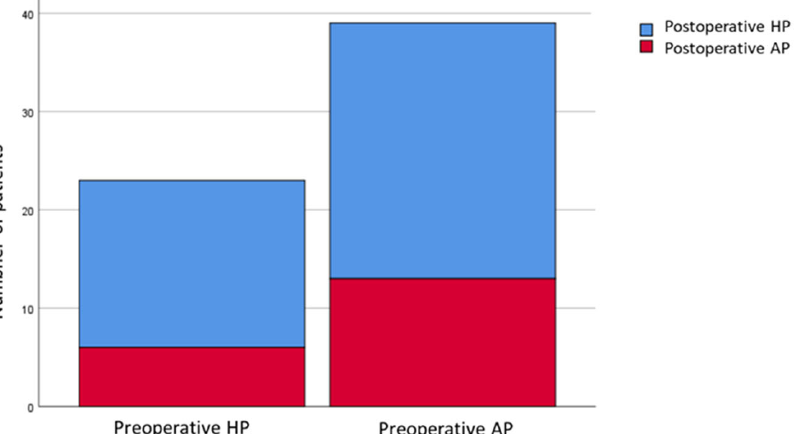
Figure 2. Distribution of apnea/hypopnea predominance in responders. AP, apnea ‐ predominant; HP, hypopnea ‐ predominant. HP, hypopnea-predominant.